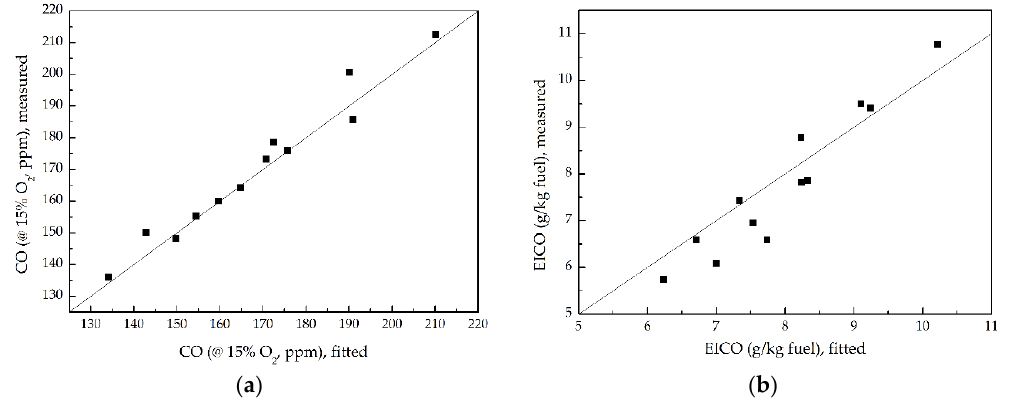
Figure 18. Predictions of CO and EICO from their correlations: ( a ) CO; ( b ) EICO